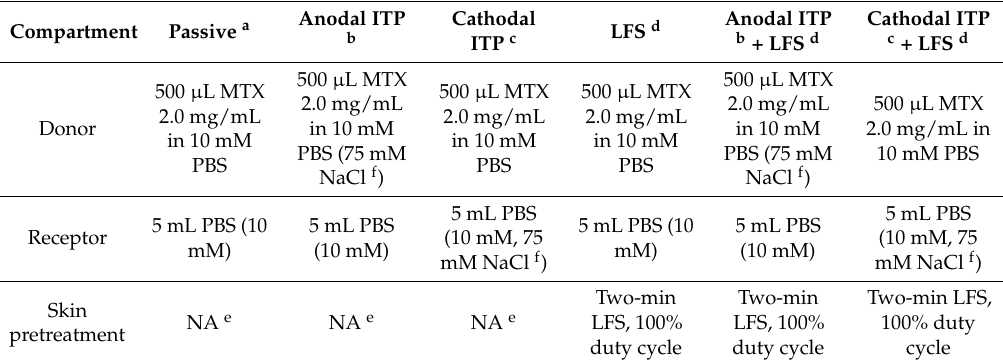
Table 1. Experimental setup of in vitro permeation studies ( n =